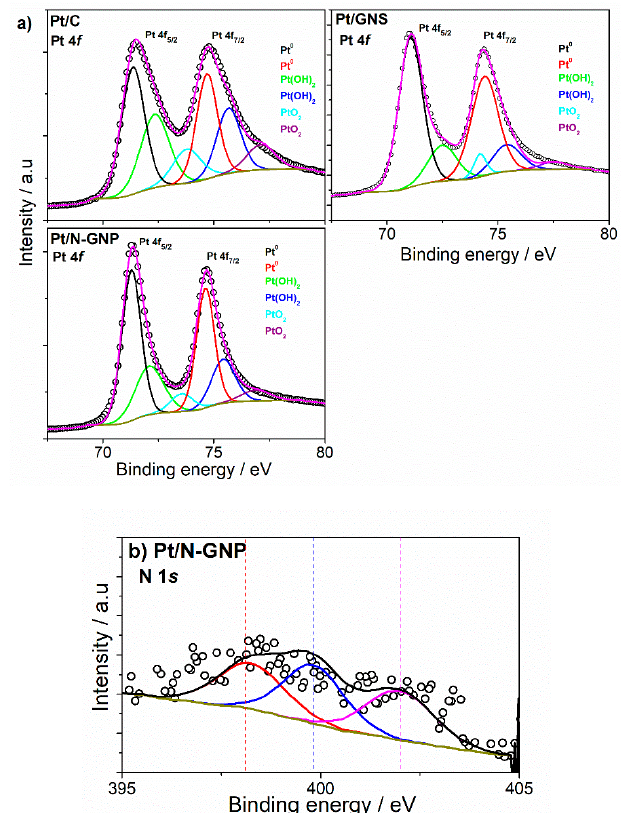
Figure 3. XPS (X-ray Photon Spectroscopy) spectra of ( a ) Pt 4 f of Pt/C, Pt/GNS, and Pt/N-GNP catalysts and ( b ) Pt/N-GNP N 1s. Table 2. Amount of Pt 4f and N 1s oxidation states (at %) in Pt / C, Pt / GNS, and Pt / N-GNP by XPS analysis.